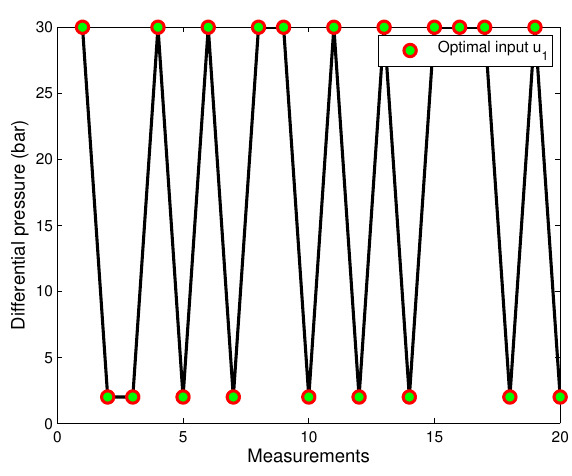
Figure 7. Additional dedicated data samples selected for input u 1 .